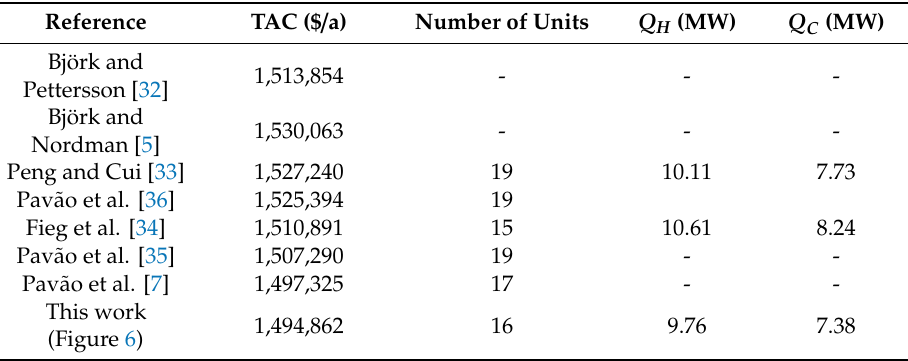
Table 6. Comparison results of case 3.